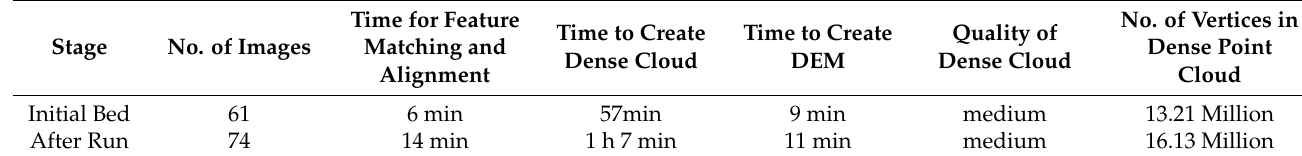
Table 3. Processing time and output quality for Case study II.